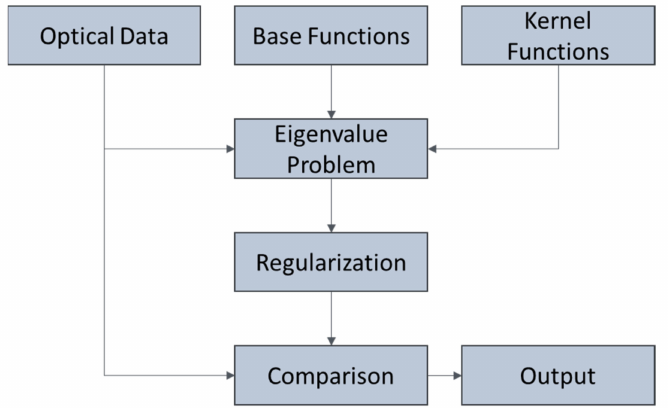
Figure 24. Regularization approach to the inverse problem from